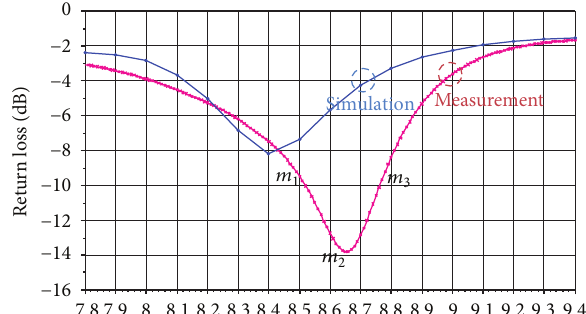
F 13: Measured and simulated return loss for the antenna. e